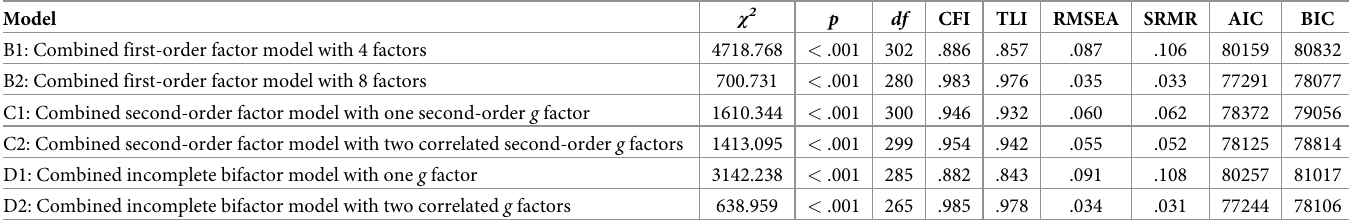
Table 4. Goodness-of-fit indices for the different combined models.